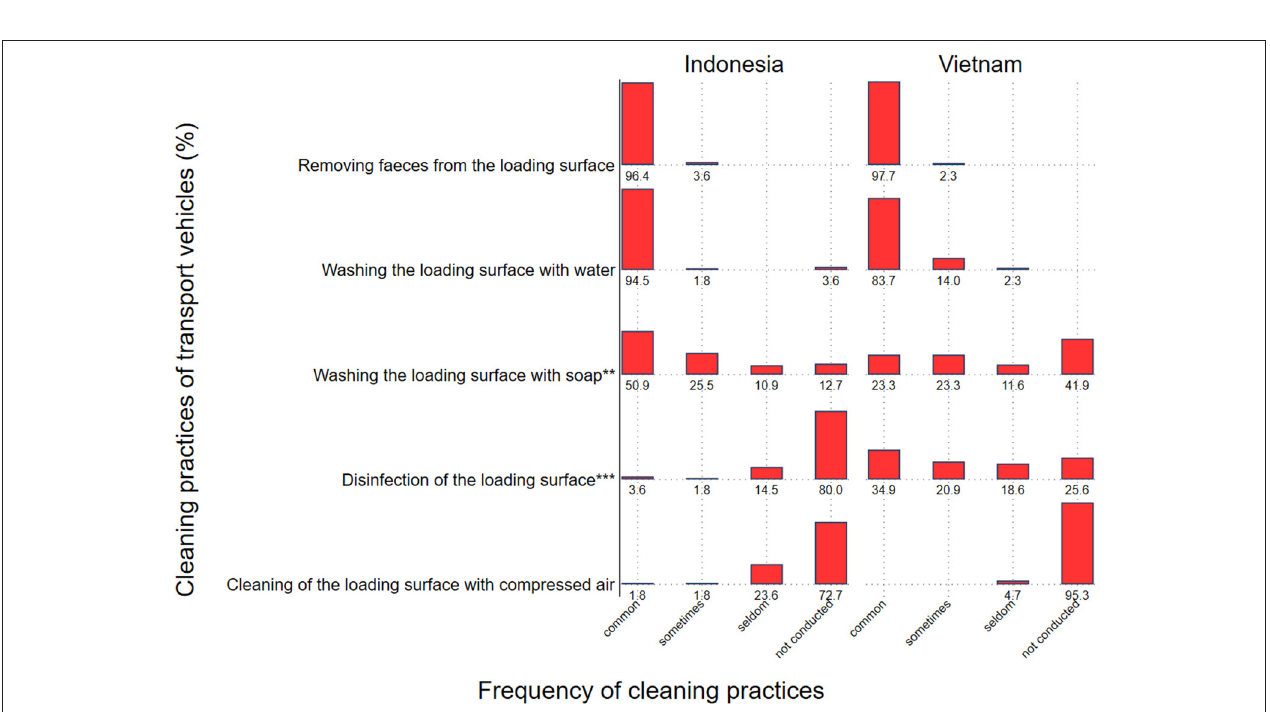
FIGURE 3 | Cleaning practices conducted on transport vehicles in Indonesia ( N = 55) and Vietnam ( N = 43) with percent of respondents by frequency category. P -values for comparisons between countries for each category are presented as follows: ** for P ≤ 0.01, *** for P ≤ 0.001.